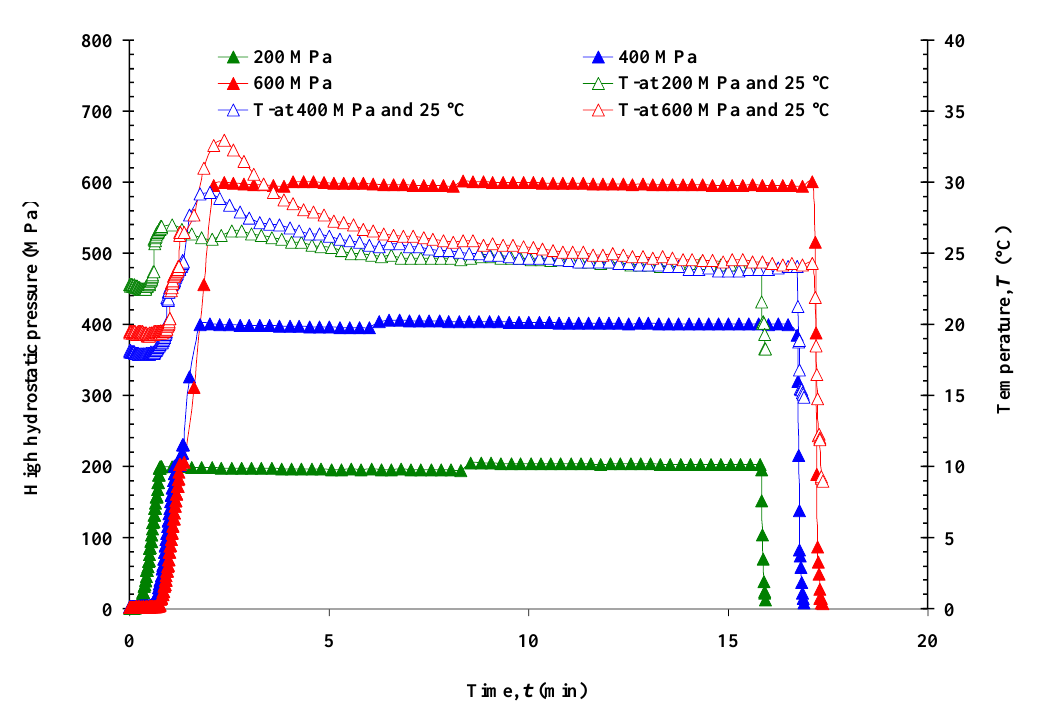
Figure 1. Representation of the temperature and pressure vs. time variation during HHP treatments (200, 400, and 600 MPa at 25 °C for 15